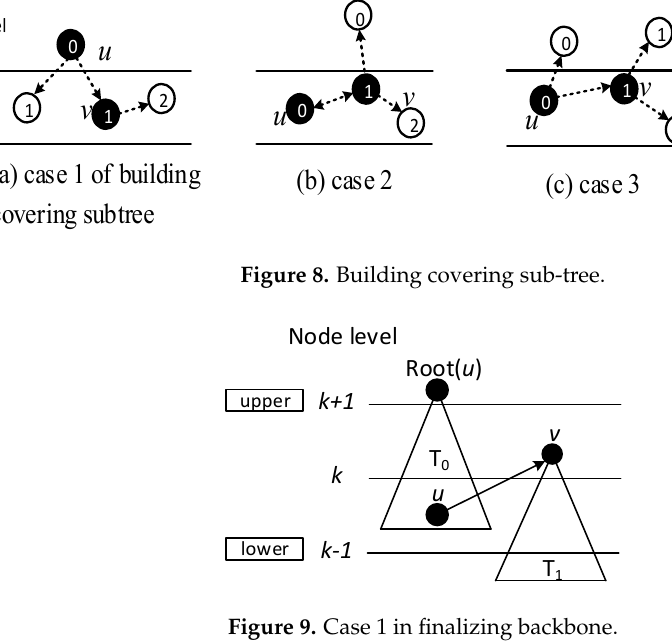
Figure 9. Case 1 in finalizing backbone.